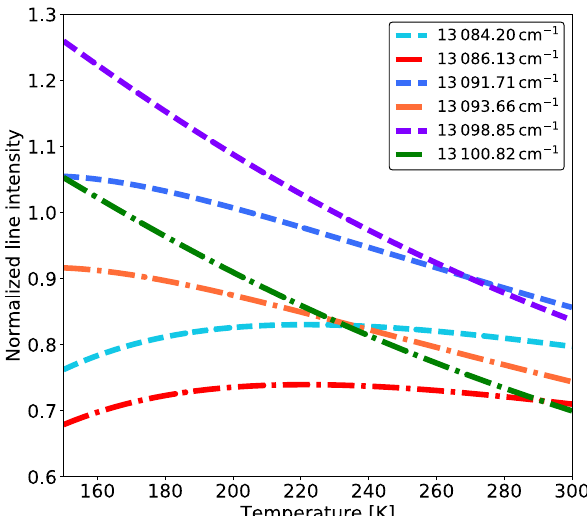
Figure 3. Temperature dependence of six rotational lines of the O 2 A-band emission. The center wavenumbers of individual lines are given in the figure legend. The intensity is normalized around the maximum intensity for a temperature of 230K.